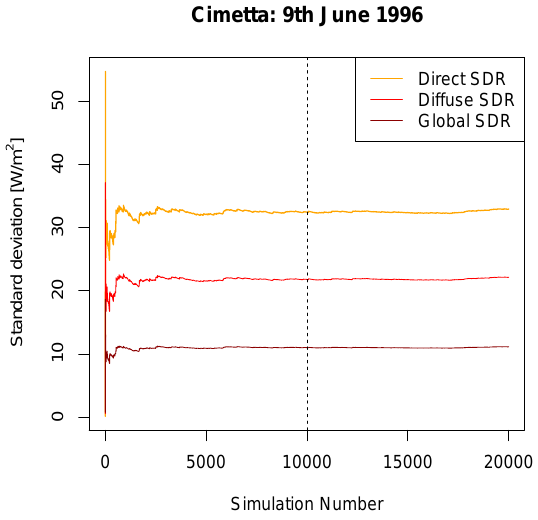
Fig. 2. Standard deviations of the model simulations at Cimetta. 10000 model simulations result sufficient to reach stable standard deviations of the output frequency